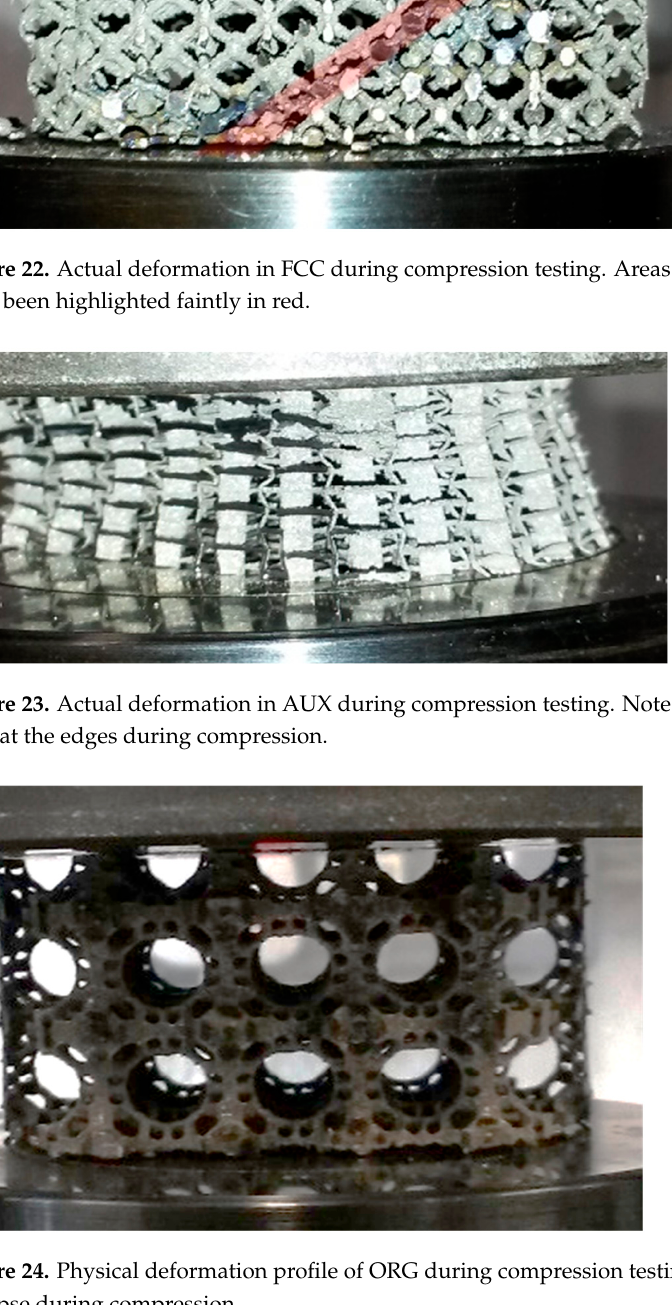
Figure 24. Physical deformation profile of ORG during compression testing. Note the uniformity of collapse during compression .